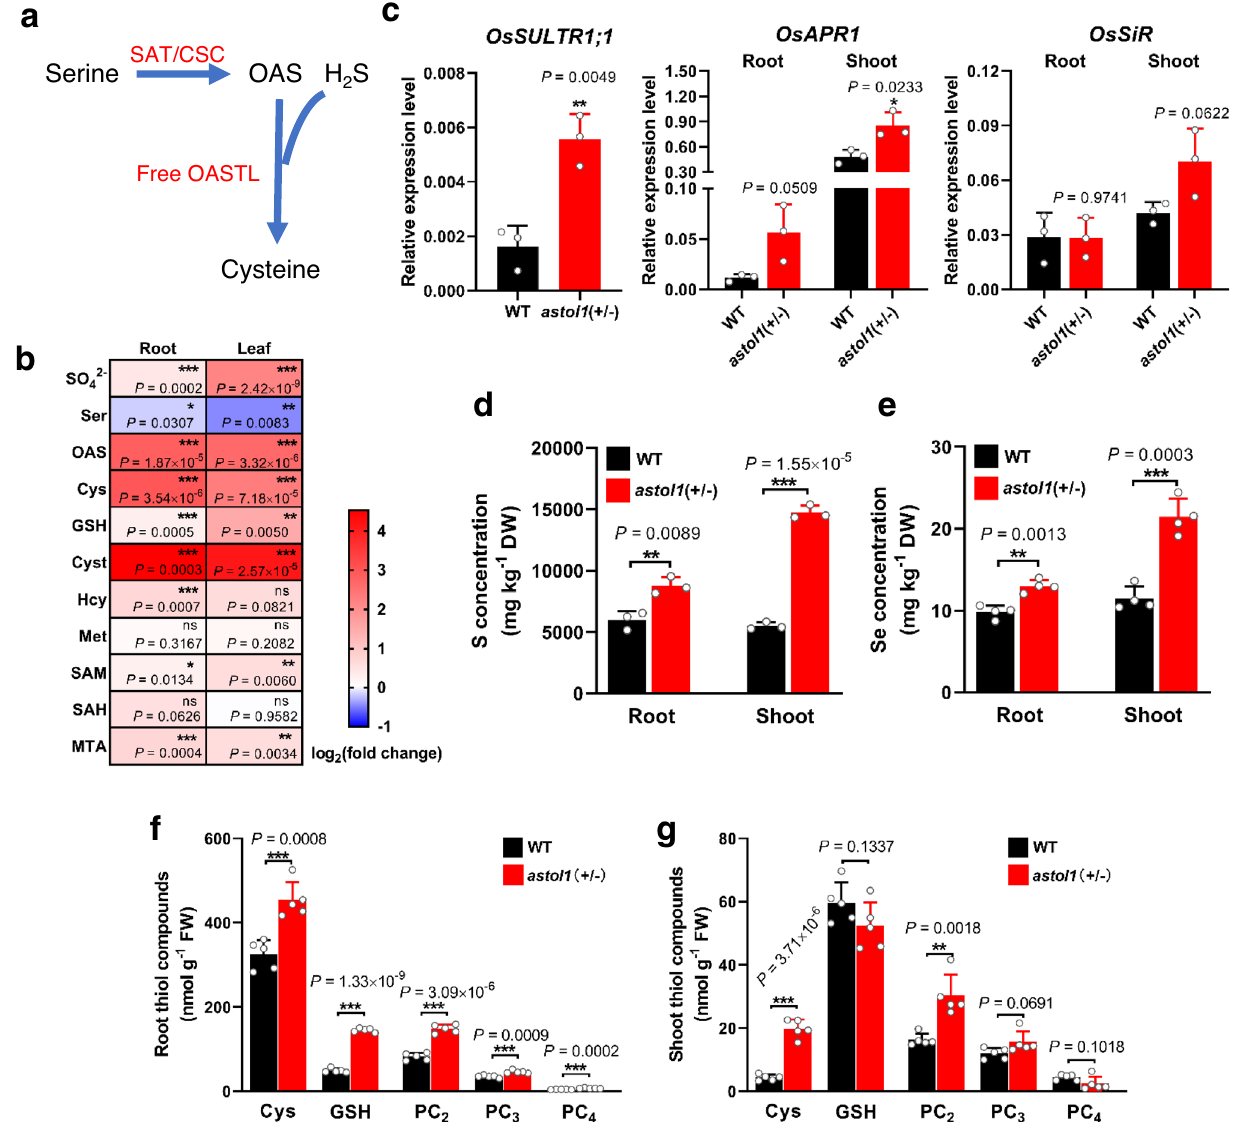
Fig. 4 astol1 mutant enhances S and Se uptake and phytochelatins-dependent As detoxi fi cation. a Metabolic pathway from serine to cysteine. b Relative fold change of S-related metabolites in astol1 ( + / − ) compared to WT, visualized as the heat map ( n = 5 biological replicates for sulfate, three biological replicates for all other metabolites; each biological replicate represents an individual plant). Abbreviations of metabolites: SO 4 2 − sulfate, Ser serine, OAS O - acetylserine, Cys cysteine, Cyst cystathionine, GSH glutathione, Hcy homocysteine, Met methionine, SAH S -adenosylhomocysteine, SAM S - adenosylmethionine, MTA methylthioadenosine. c Relative expression levels of rice genes involved in sulfate uptake and reduction in the roots and shoots of 3-week-old WT and astol1 ( + / − ). Transcriptional induction of selected rice genes ( OsSULTR1;1 (Os03g0195800) in roots, OsAPR1 (Os07g0509800) and OsSiR (Os05g0503300) in roots and shoots) was measured by Q-PCR, with OsHistone H3 as the internal reference gene. d S concentrations in roots and shoots of 5-week-old WT and astol1 ( + / − ). e Se concentrations in roots and shoots of 5-week-old WT and astol1 ( + / − ) exposed to 2 μ M Se(VI) for 3 days. The concentrations of non-protein thiols in roots ( f ) and shoots ( g ) of 4-week-old WT and astol1 ( + / − ) treated with 5 μ M As(III) for 3 days. DW, dry weight. FW, fresh weight. WT, wild type. astol1 ( + / − ), astol1 heterozygote. Data in c – g are shown as means ± s.d. n = 3 ( c , d ), 4 ( e ) or 5 ( f , g ) biological replicates; each biological replicate represents an individual plant. Asterisks in b – g indicate signi fi cant differences by two-sided Student ’ s t test: * P < 0.05, ** P < 0.01, *** P <